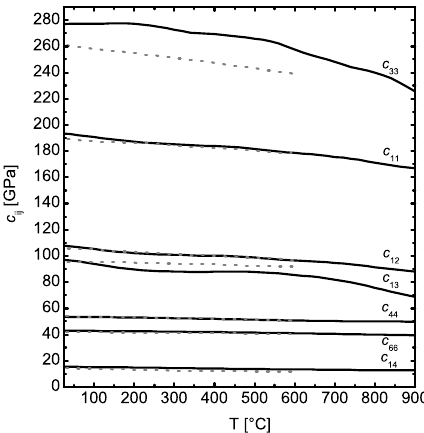
Figure 6. The full set of elastic stiffness coefficients of langasite as function of temperature calculated from BAW measurements (solid line) in comparison with the data obtained by Weihnacht et al. (2012) (dotted line).